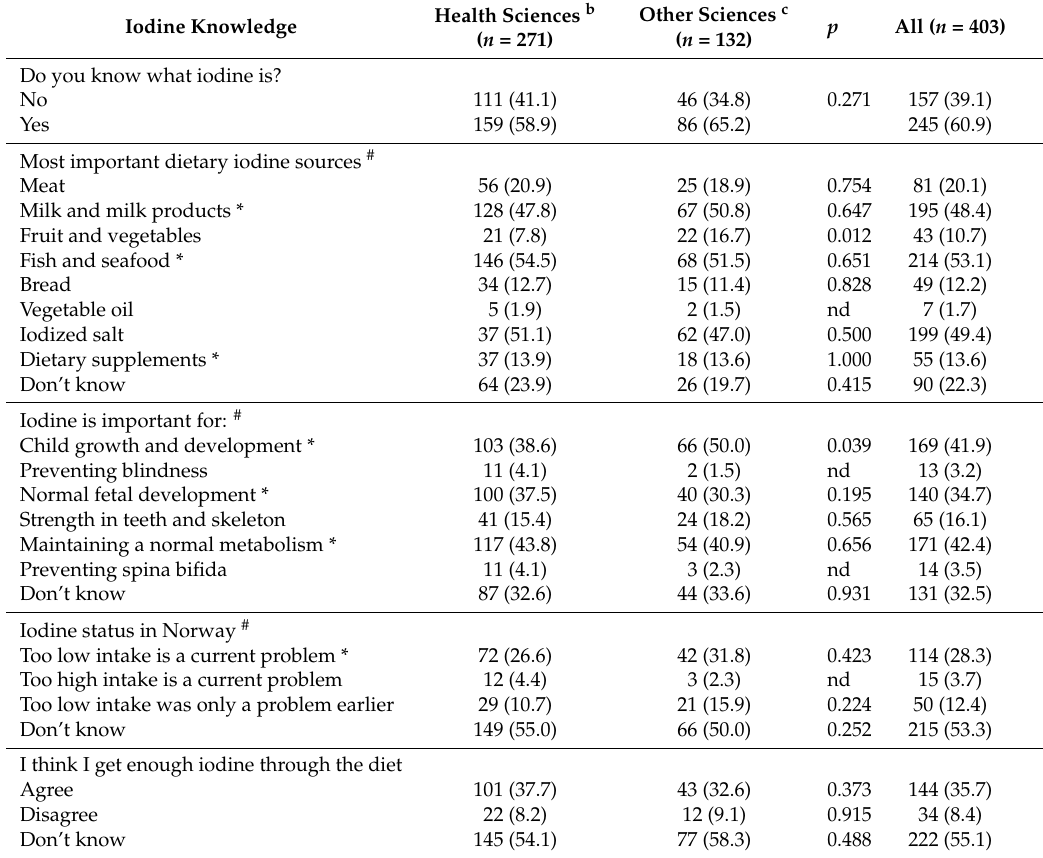
Table 4. Iodine knowledge in young Norwegian women attending health related study programs and other study programs ( n = 403)